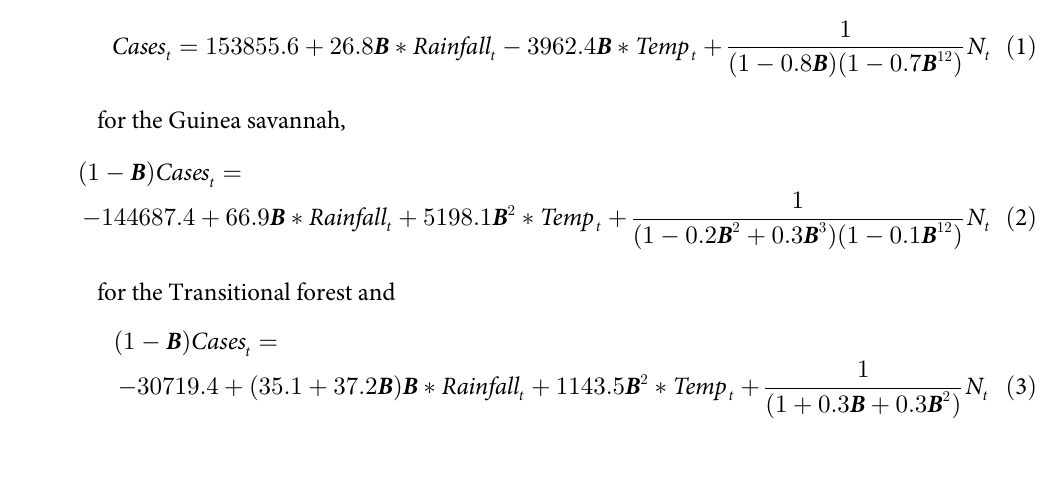
slightly. Effect of rainfall in the previous two months significantly influences the incidence of malaria in the Coastal savannah. The effect of temperature in the Coastal savannah is however similar to its observed effect in the Transitional forest zone. These relationships remained sig- nificant even in the combined multivariable model of rainfall and temperature and malaria morbidity, Table 2, S2 and S3 Tables. Notwithstanding the seasonal component of the random error term not being significant, for both model estimates in the Transitional forest and Coastal savannah zones, the non-sea- sonal random terms were significant. As explained earlier, this may indicate some unobserved non-seasonal factors significantly explain the variability in malaria morbidity apart from tem- perature and rainfall (Table 2, S2 and S3 Tables). Transfer function models for the relationship between malaria caseloads as the dependent outcome variable and rainfall and temperature as the independent input variables were devel- oped and represented by the Eqs 1, 2 and 3 below. These are,